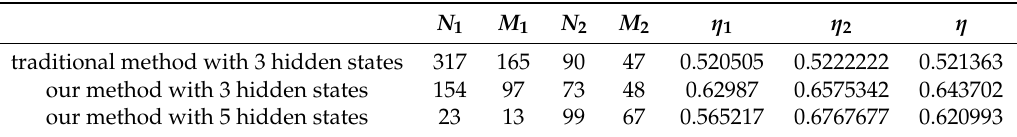
Table 2. Model accuracy.